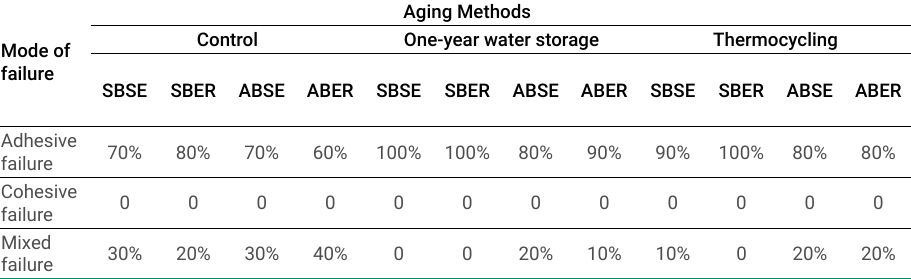
Table 3. Bond failure mode for different groups.